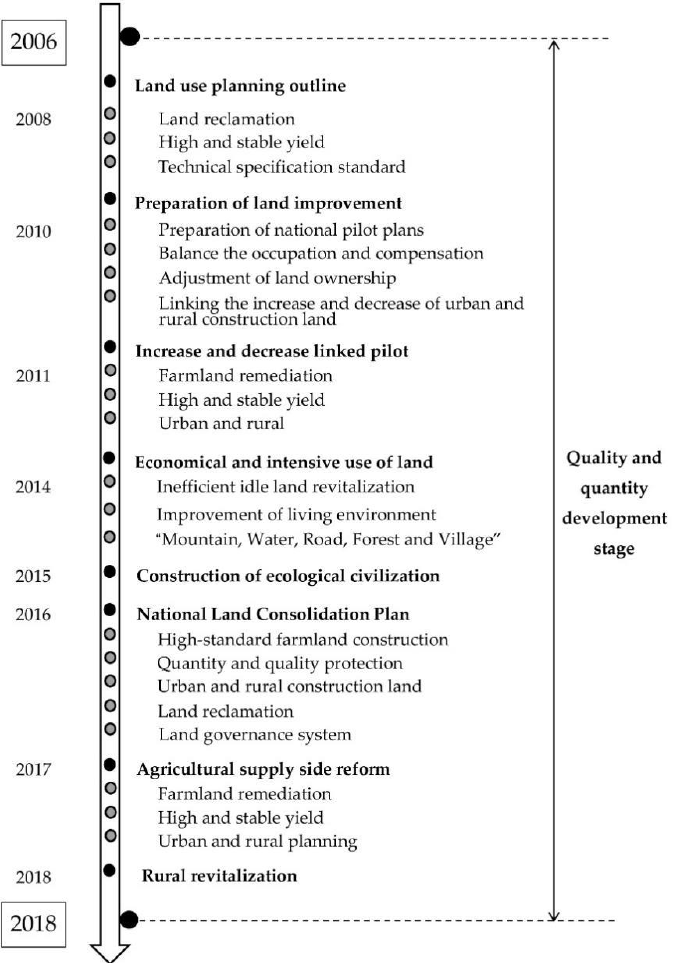
Figure 3. Schematic diagram showing development in the agriculture land supplement stage.